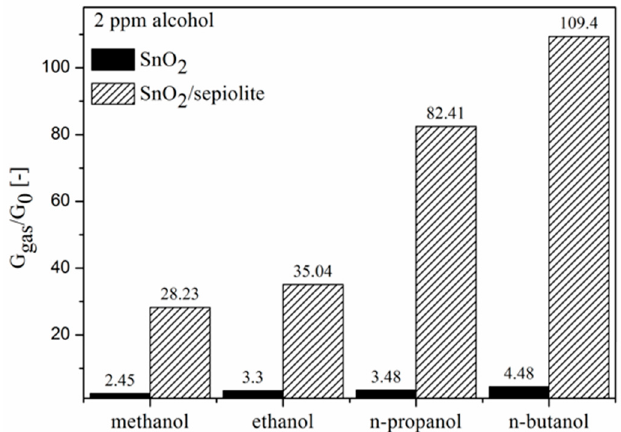
Figure 12. A comparison of the sensitivity of the two sensors on 2 ppm alcohol (air 30% RH).